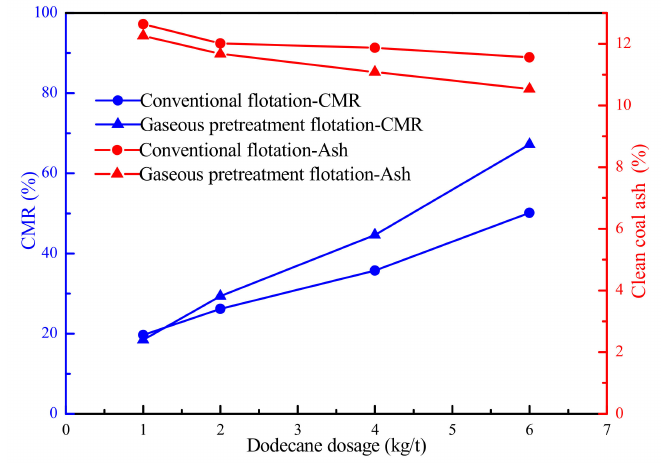
Figure 6. Flotation results of LRC in the presence of conventional flotation and the gaseous pretreatment flotation method.